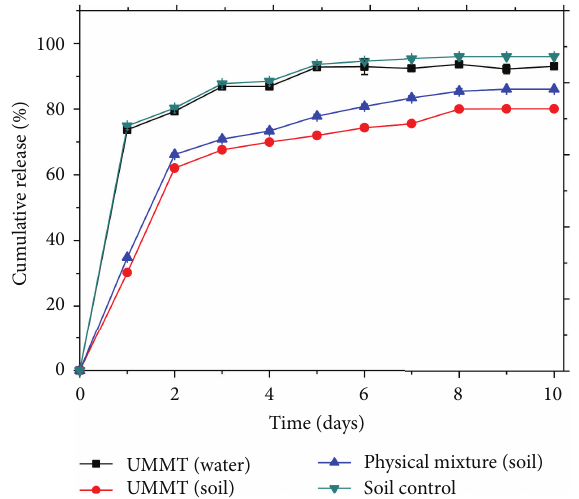
Figure 11: Timedependence release of urea from UMMTnanocom- posite in water and soil.